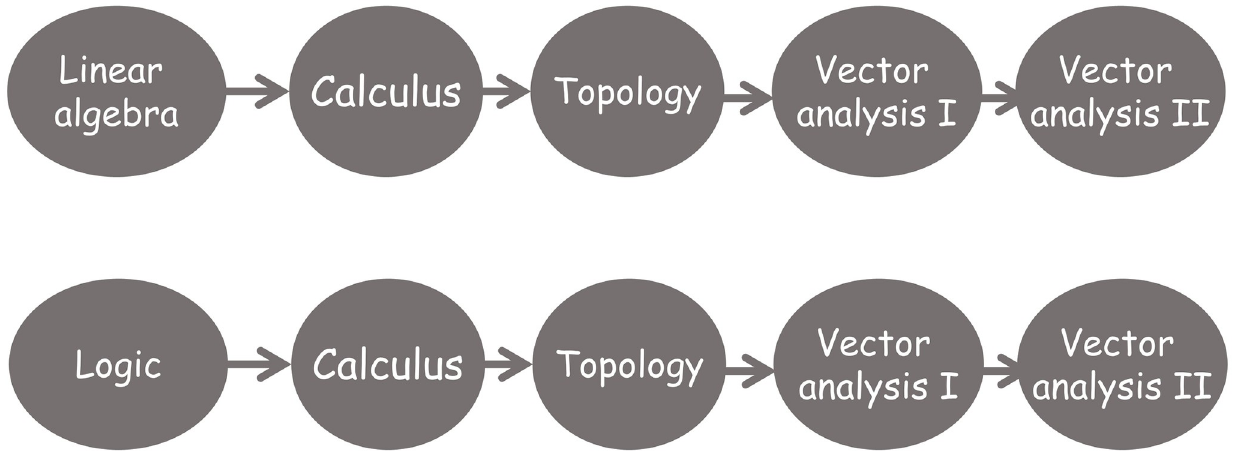
Fig 5. Example of allocation of course Calculus in a training itinerary taking into consideration the maximum length of the path that joints the course with any other course in the associated dependency